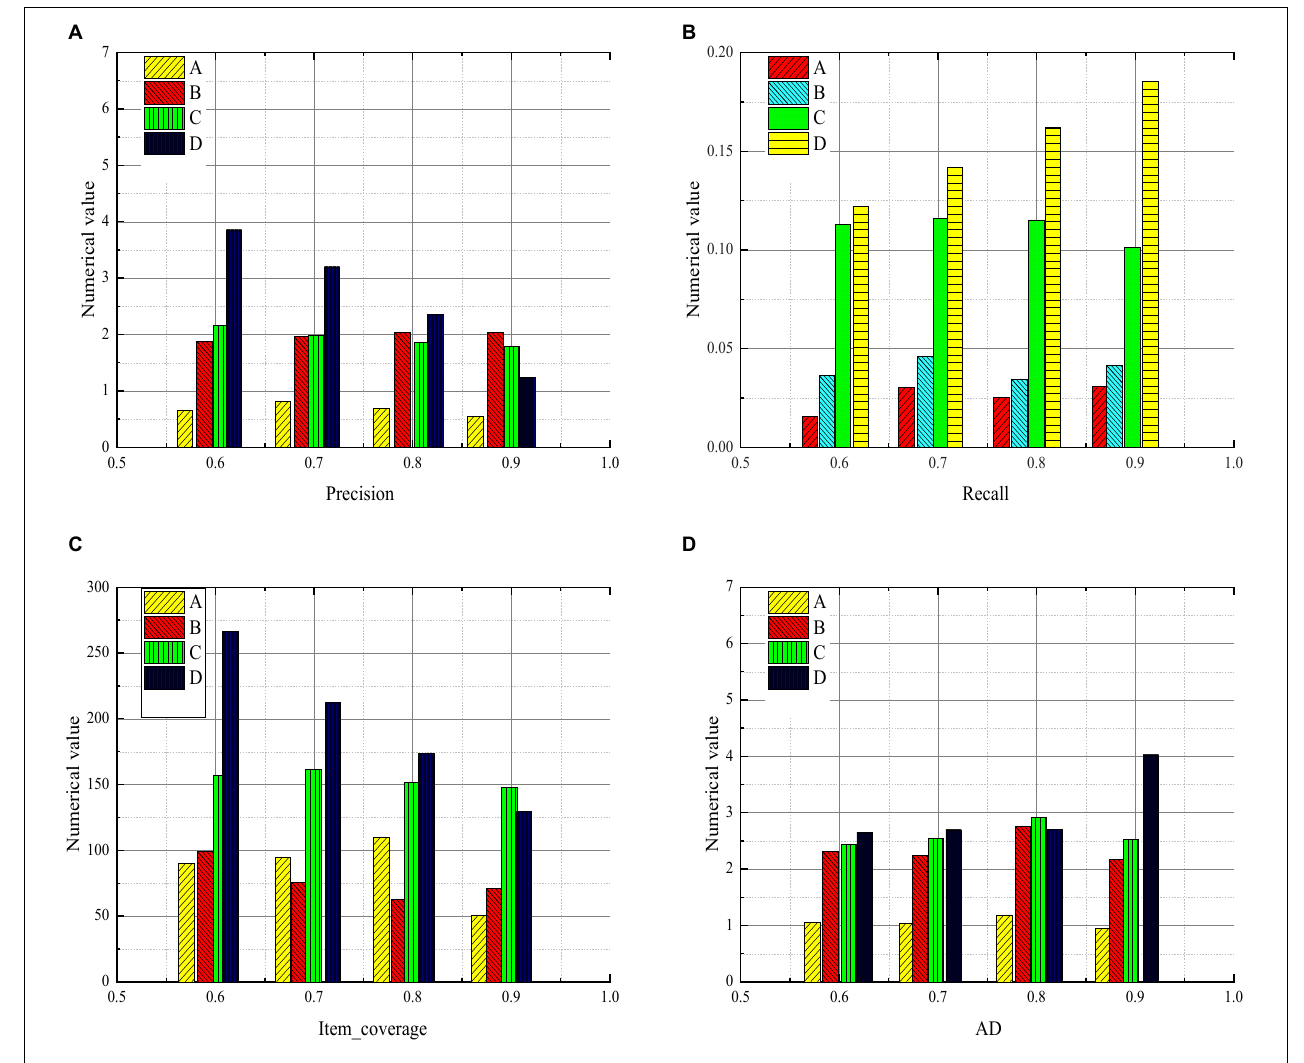
FIGURE 5 | Statistics of experimental data ( A: UserCF method; B: LTM method; C: MarkovChain method; D: Adaptive learning and deep learning mode of sports psychology teaching method).